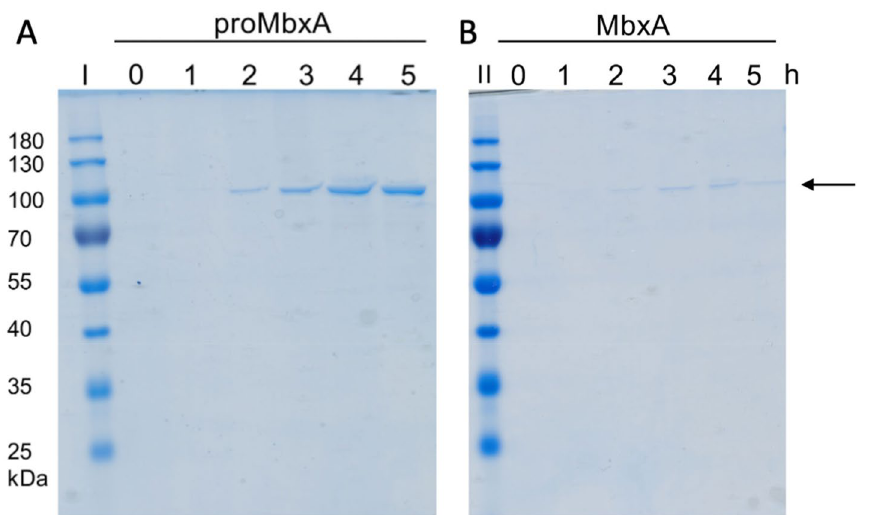
Figure 3. Heterologous secretion of proMbxA and MbxA via the HlyBD system. The Coomassie Brilliant Blue (CBB) SDS PAGE of culture supernatants of E. coli BL21(DE3) co-expressing HlyBD and MbxA (proMbxA, ( A )) or HlyBD, HlyC and MbxA (MbxA, ( B )) show accumulation of proMbxA or MbxA during a period of 0–5 h of expression (indicated by the numbers above the gel) after induction with IPTG. Samples of the supernatant were applied to the SDS gel without additional concentration by TCA precipitation. Molecular weight markers in kDa are shown in lanes I and II. An arrow indicates proMbxA and